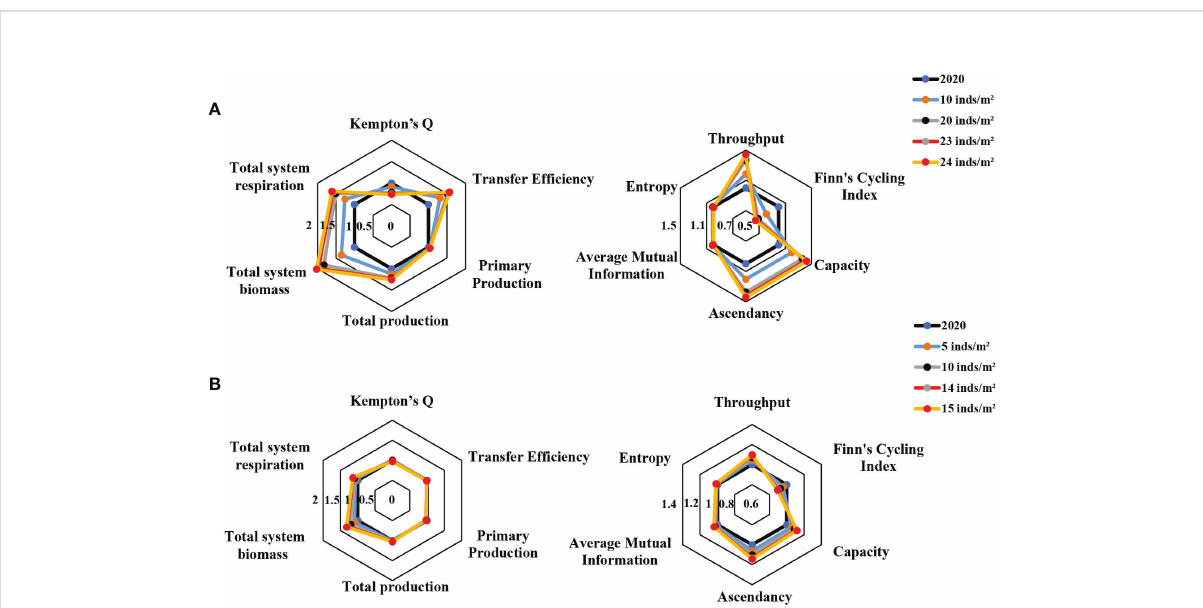
FIGURE 5 Radar plots showing the relative changes in ecological network analysis indicators predicted from the Ecopath model for the Laizhou Bay marine ranching areas under four stock enhancement scenarios for (A) the red snail Rapana venosa and (B) and the sea cucumber